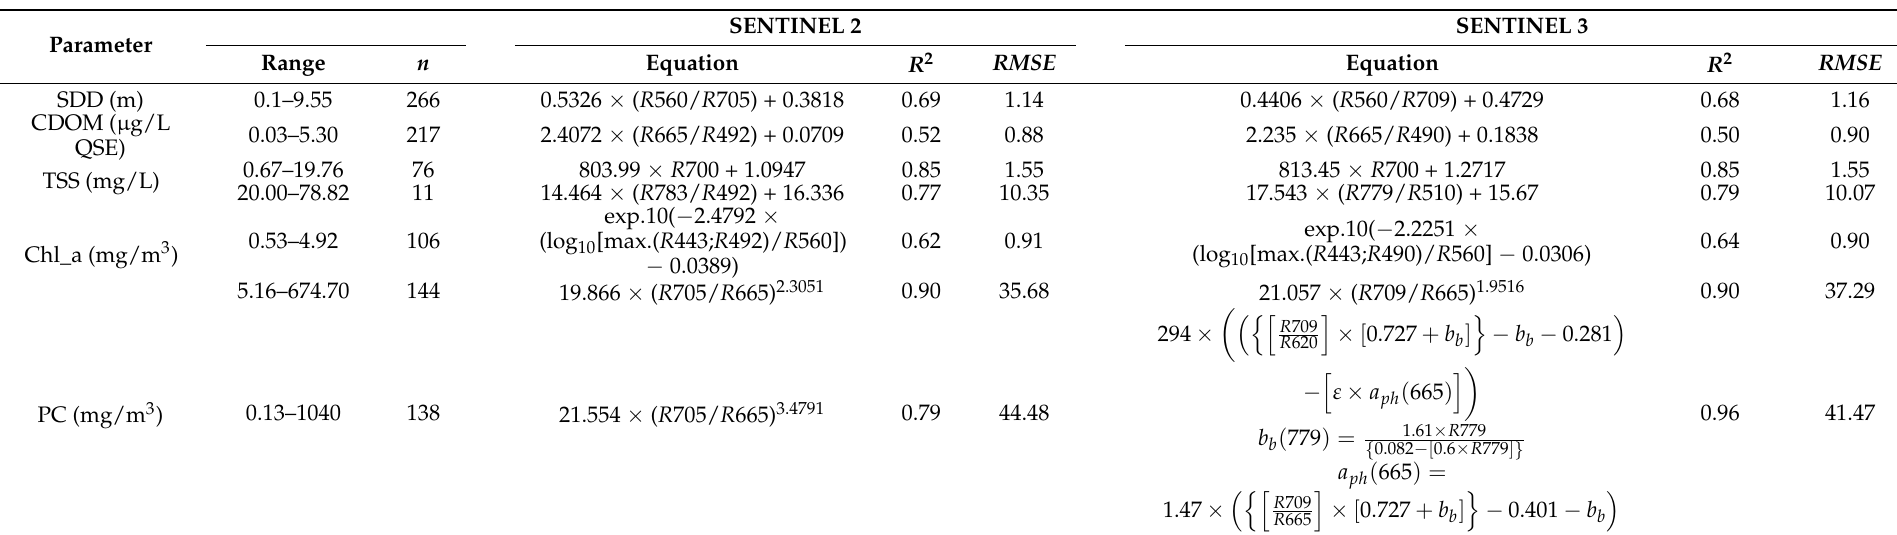
Table 10. Summary of retrieval